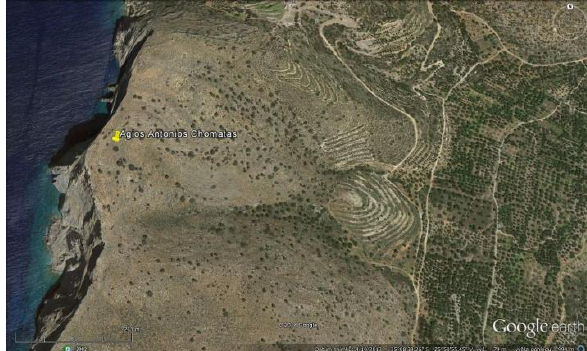
Figure 4. Agios Antonios Chomatas Site 9: Google Earth image of the site’s